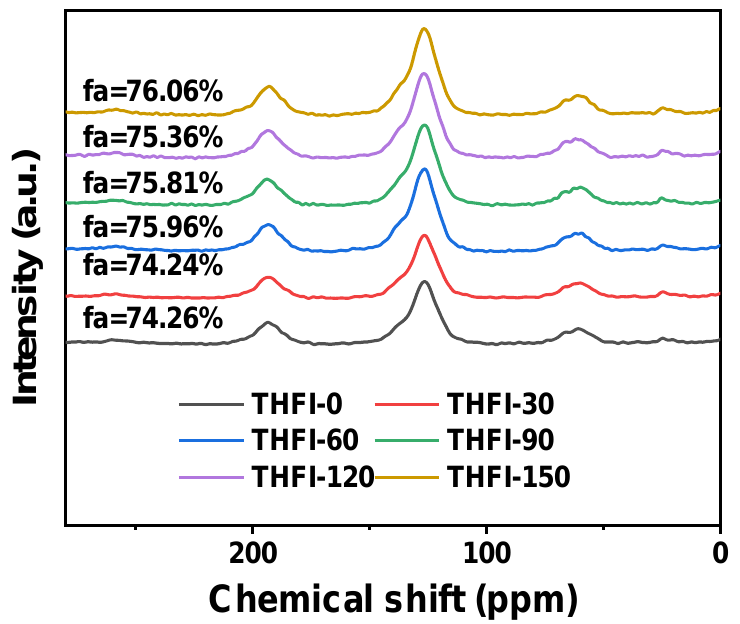
>S=O Figure 13. FT − IR spectra of the THFI fraction. Figure 14 shows the 13 C − NMR spectra of the THFI fraction. The aromatic carbon con-